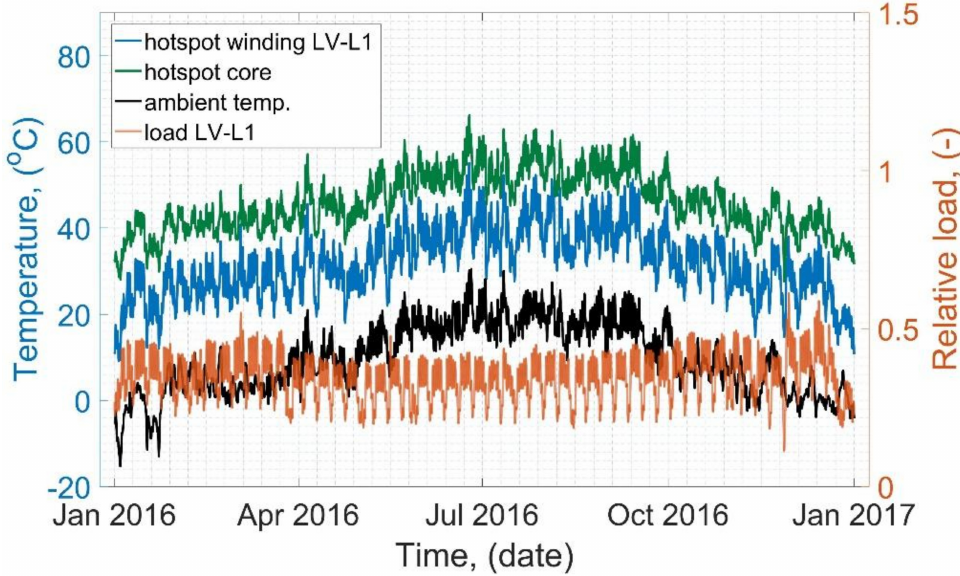
Figure 2. Exemplary temperature and load variability of the Tr1.